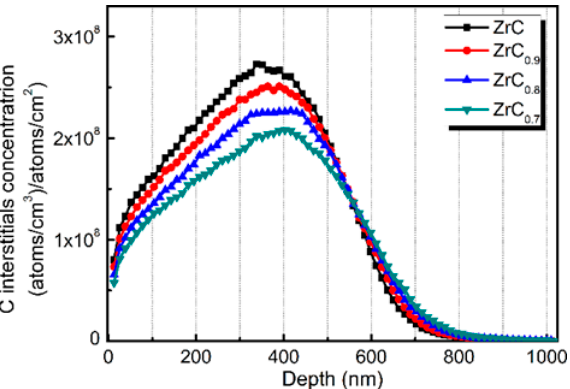
Figure 2. SRIM prediction for ( a ) damage production and ( b ) implanted Au distributions for ZrC x with different stoichiometries, calculated with SRIM under irradiation of a fluence of 2 × 10 16 ions/cm 2 by a four MeV Au ion beam.